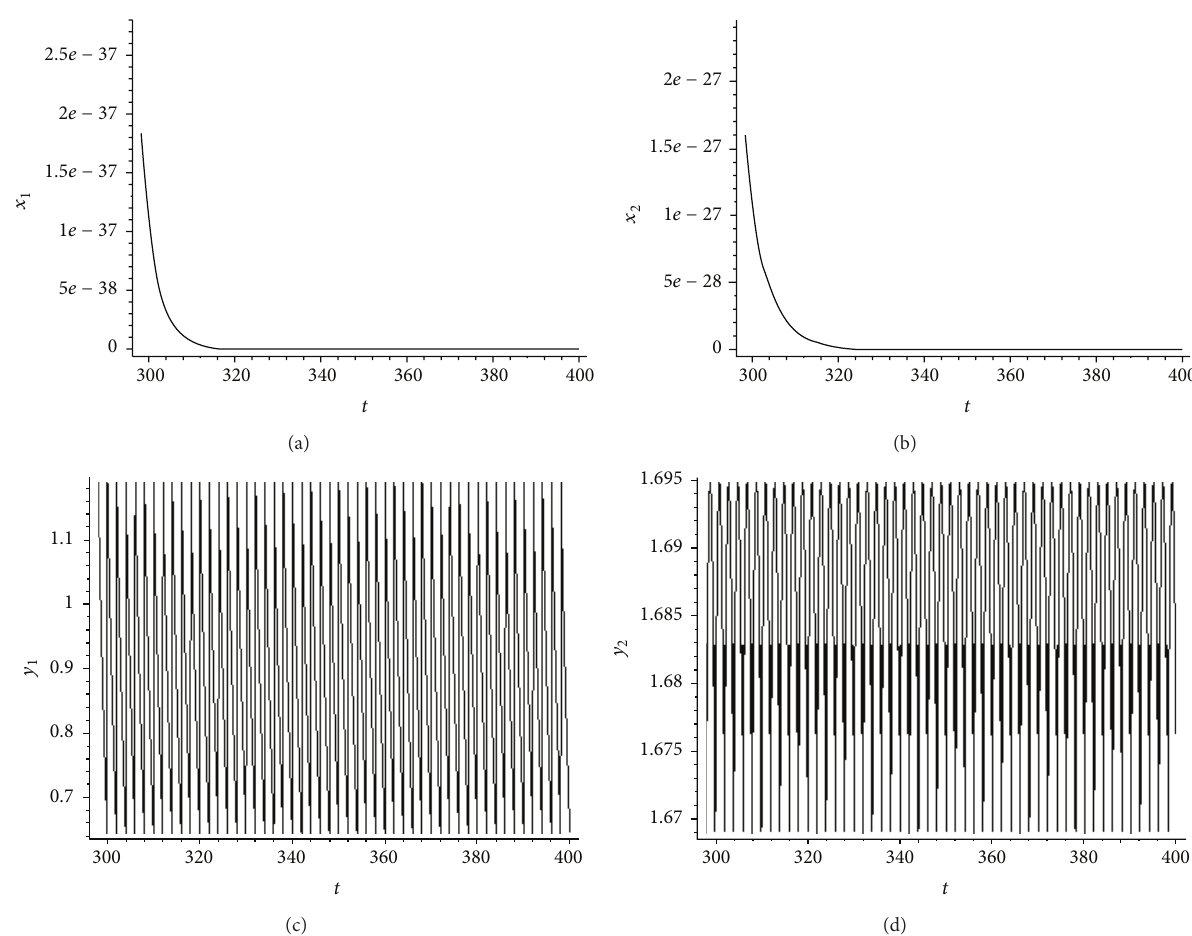
Figure 1: Globally asymptotically stable prey eradication solution of system (3). (a, b) Time series of prey populations 𝑥 1 (𝑡) , 𝑥 2 (𝑡) and (c, d) time series of predator populations 𝑦 1 (𝑡) , 𝑦 2 (𝑡) with initial values 𝑥 1 (0) = 0.5 , 𝑥 2 (0) = 0.5 , 𝑦 1 (0) = 0.5 , and 𝑦 2 (0) = 0.5